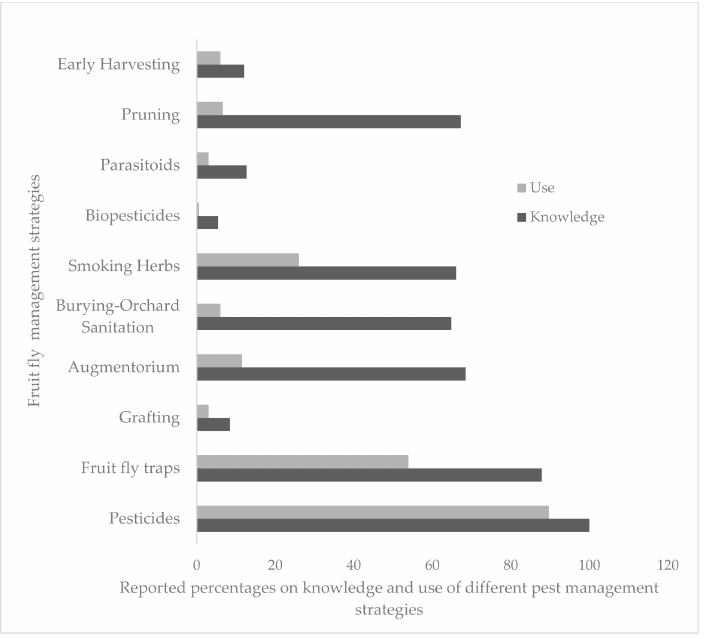
Figure 3. Knowledge and use of different fruit fly management practices in Embu